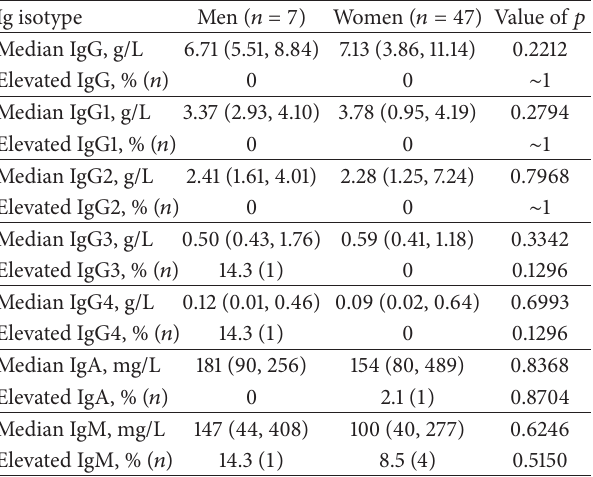
Table 1: Serum immunoglobulins in 54 adults with